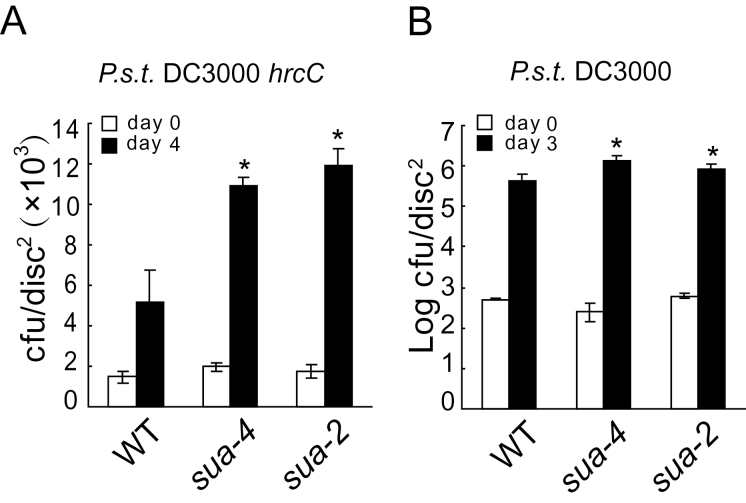

rsn1 Mutants Compromise PAMP-Triggered Immu nity and Basal Resistance.Growth of P.s.t. DC3000hrcC (A) or P.s.t. DC3000 (B) on wild-type, sua-4, and sua-2 plants. Four-week-old soil-grown plants were challenged with P.s.t. DC3000hrcC (OD600 = 0.001) or P.s.t. DC3000 (OD600 = 0.0002). Error bars represent standard deviations of six repeats. Asterisks above the bars indicate significant difference from WT. P < 0.001 (A); P < 0.05 (B).